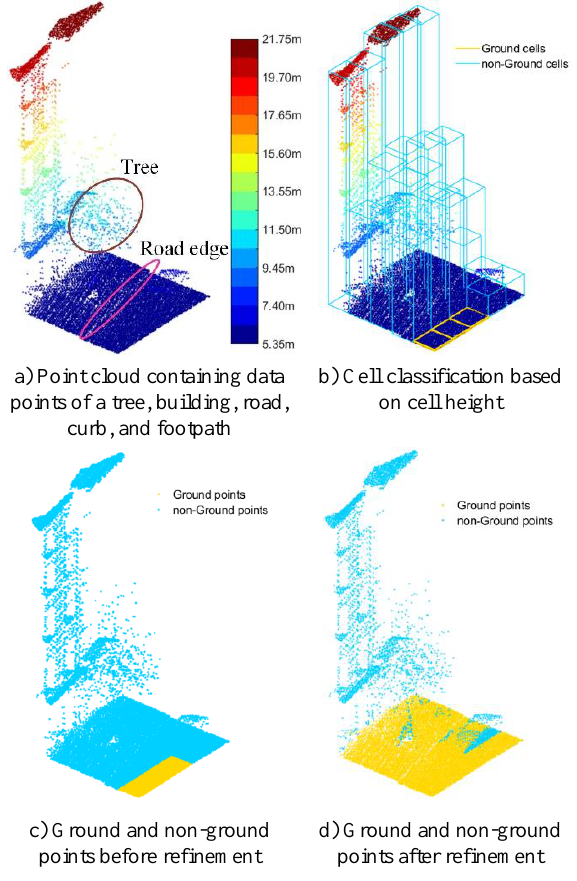
Figure 2. Extract cell-based ground point extraction